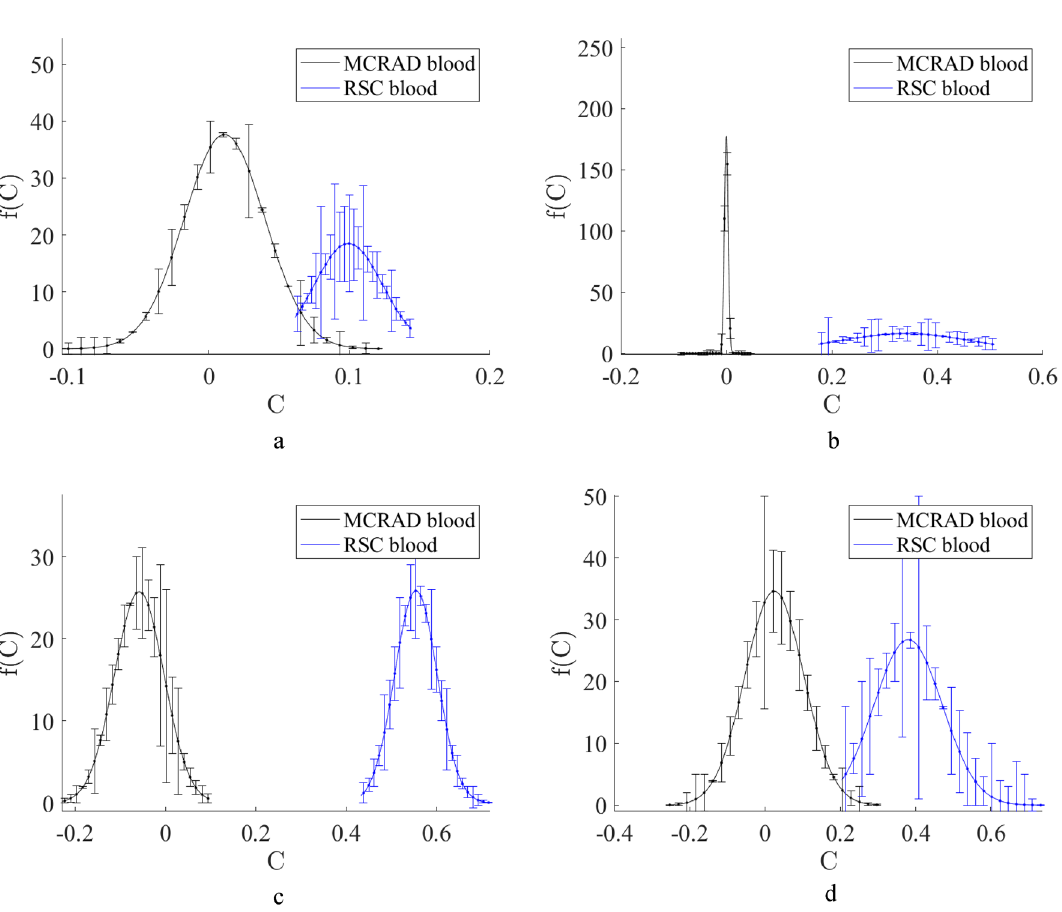
Figure 4. The blood volume fraction restored by MCRAD and RSC in experimental Raman spectra of bloodstains on blue polyester ( a ), denim ( b ), cotton fabric ( c ), and white polyester ( d )